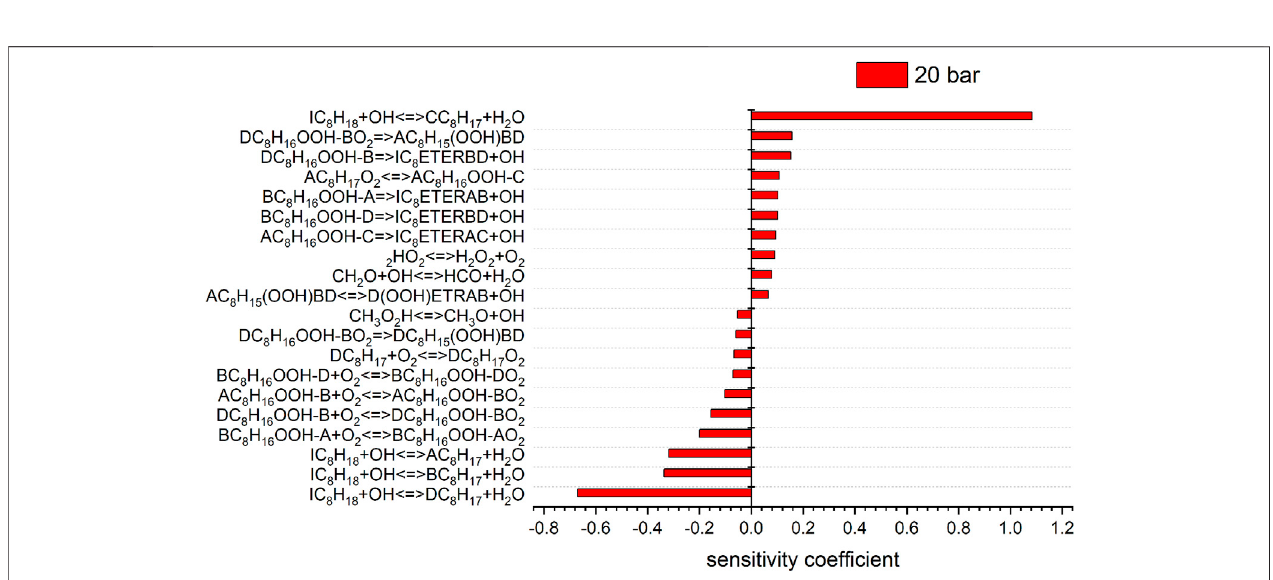
FIGURE 8 | Sensitivity analysis of C 8 H 18 on reaction rate coef fi cients performed with the model of Atef et al. at 10 (sensitivity coef fi cients = 0) and 20 bar, 623 K .